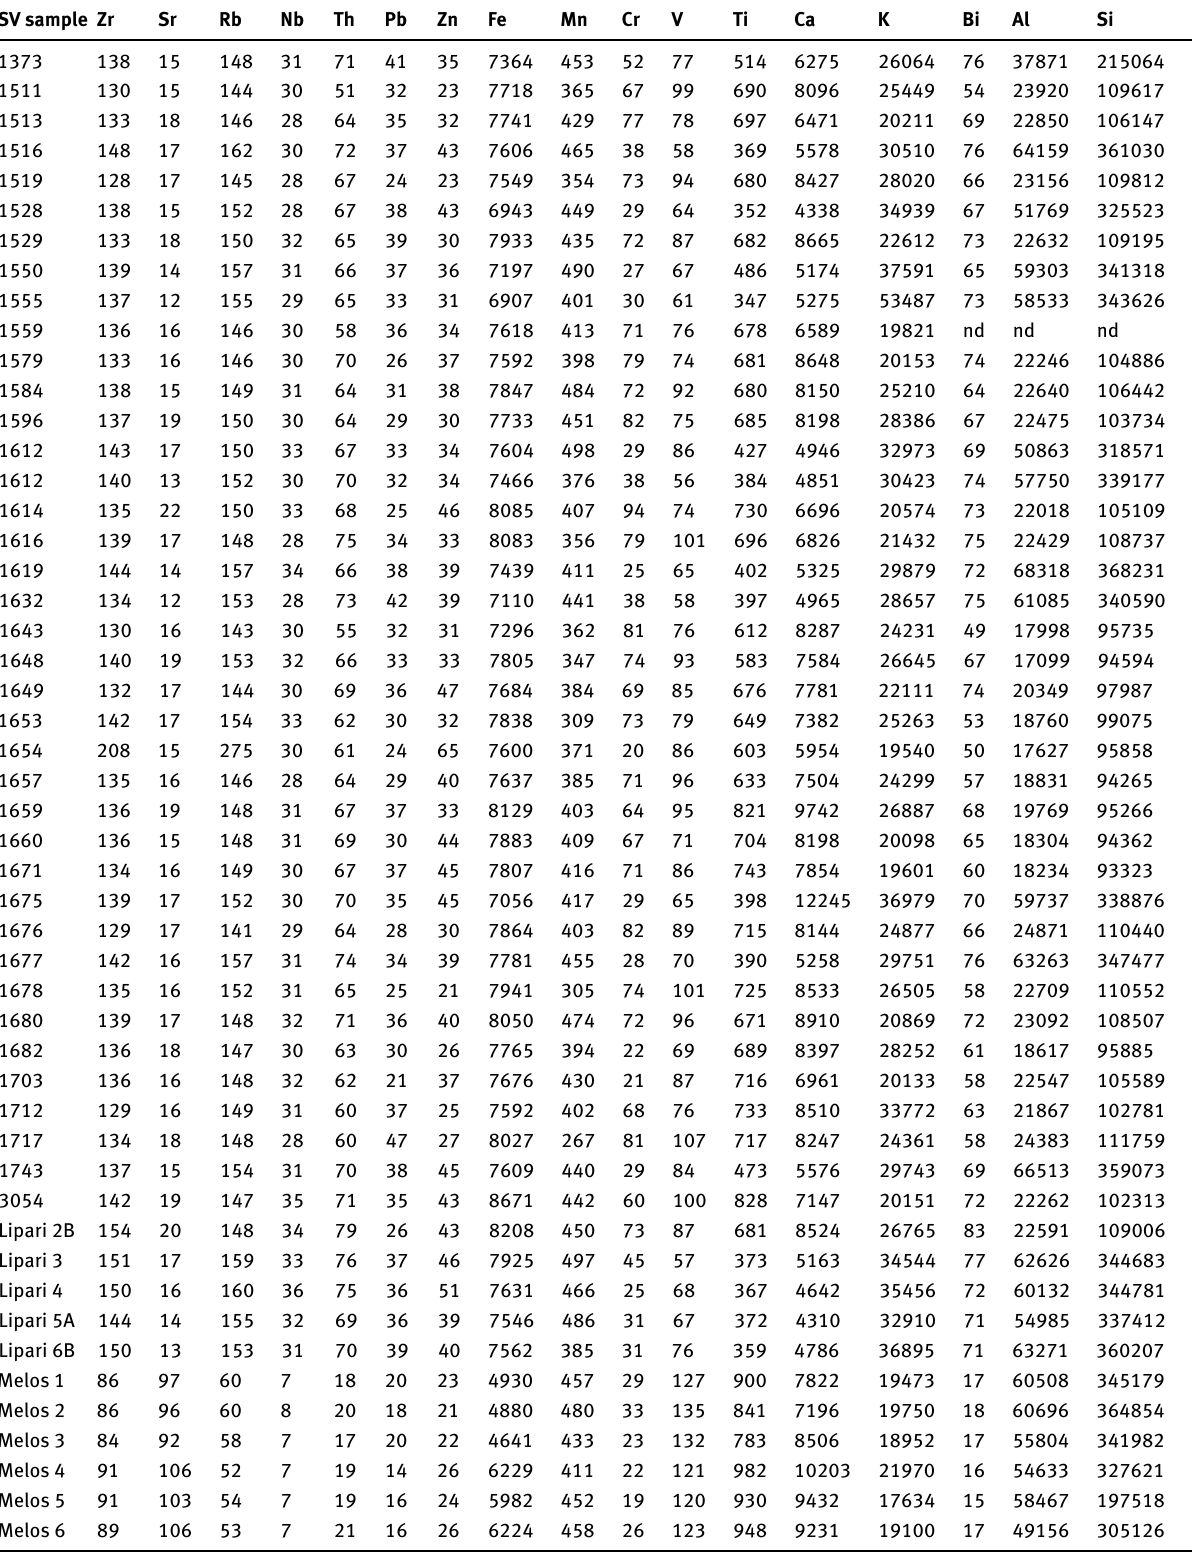
Table 1. Chemical compositions of the obsidian artefacts from San Vincenzo (SV) and reference material from Lipari and Melos, determined by p-XRF. Element contents are expressed in